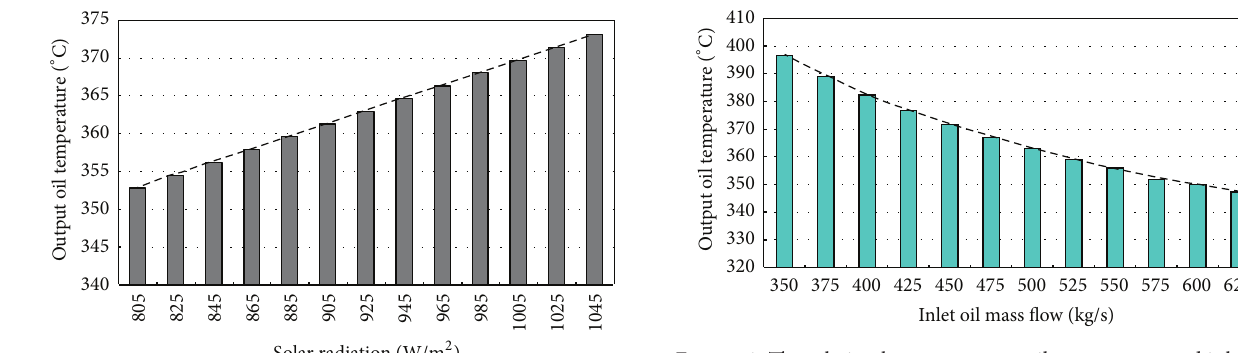
Figure 9: The relation between output oil temperature and inlet oil mass flow rate alterations.